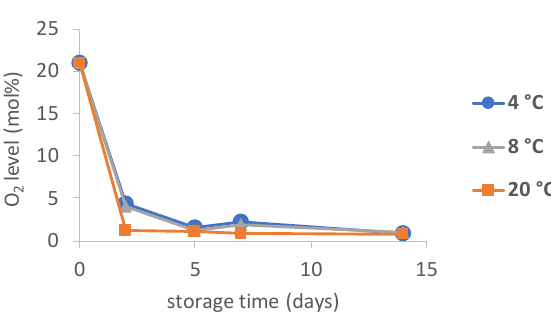
Figure 3. O 2 levels in the headspace of closed storage recipients - storage experiment 1.